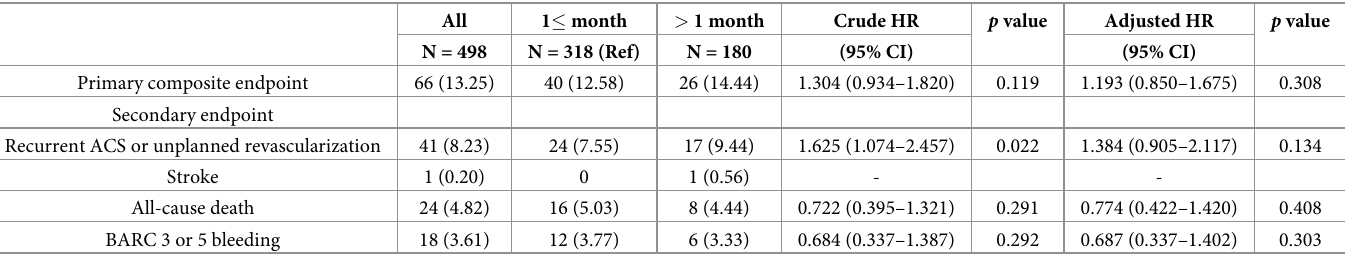
Table 3. Clinical outcomes at 12-month follow up.